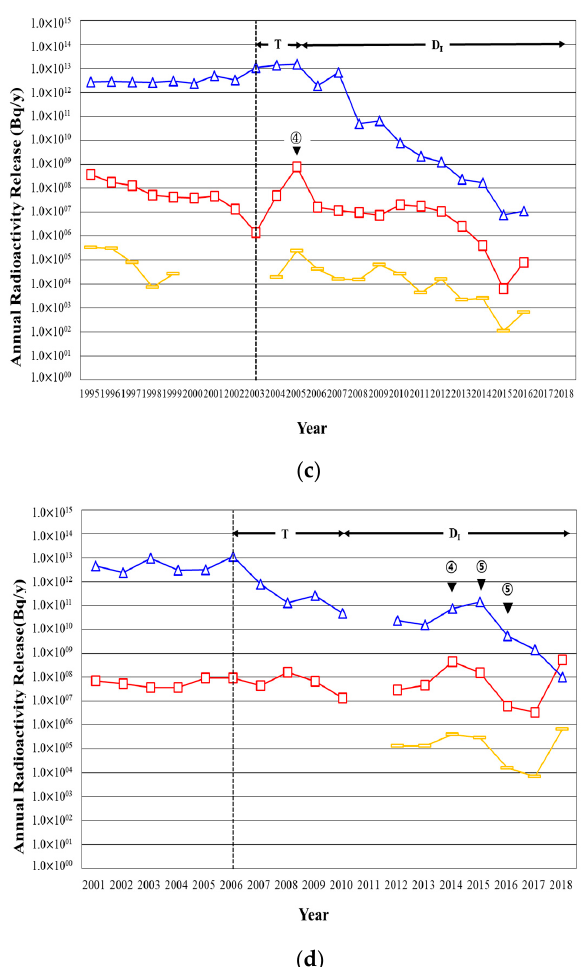
Figure 6. Annual radioactivity release of liquid effluent before and after permanent shutdown of nuclear power plants: (a) Crystal River-3; (b) Haddam Neck; (c) Stade; (d) Jose Cabrera. The number ② , ③ , ④ , and ⑤ indicate respective years for license termination, drainage of SFP, dismantling activities, and decontamination of buildings. T and D I indicate phases T and D I as specified Figure 2. The dotted line indicates the year of permanent shutdown.